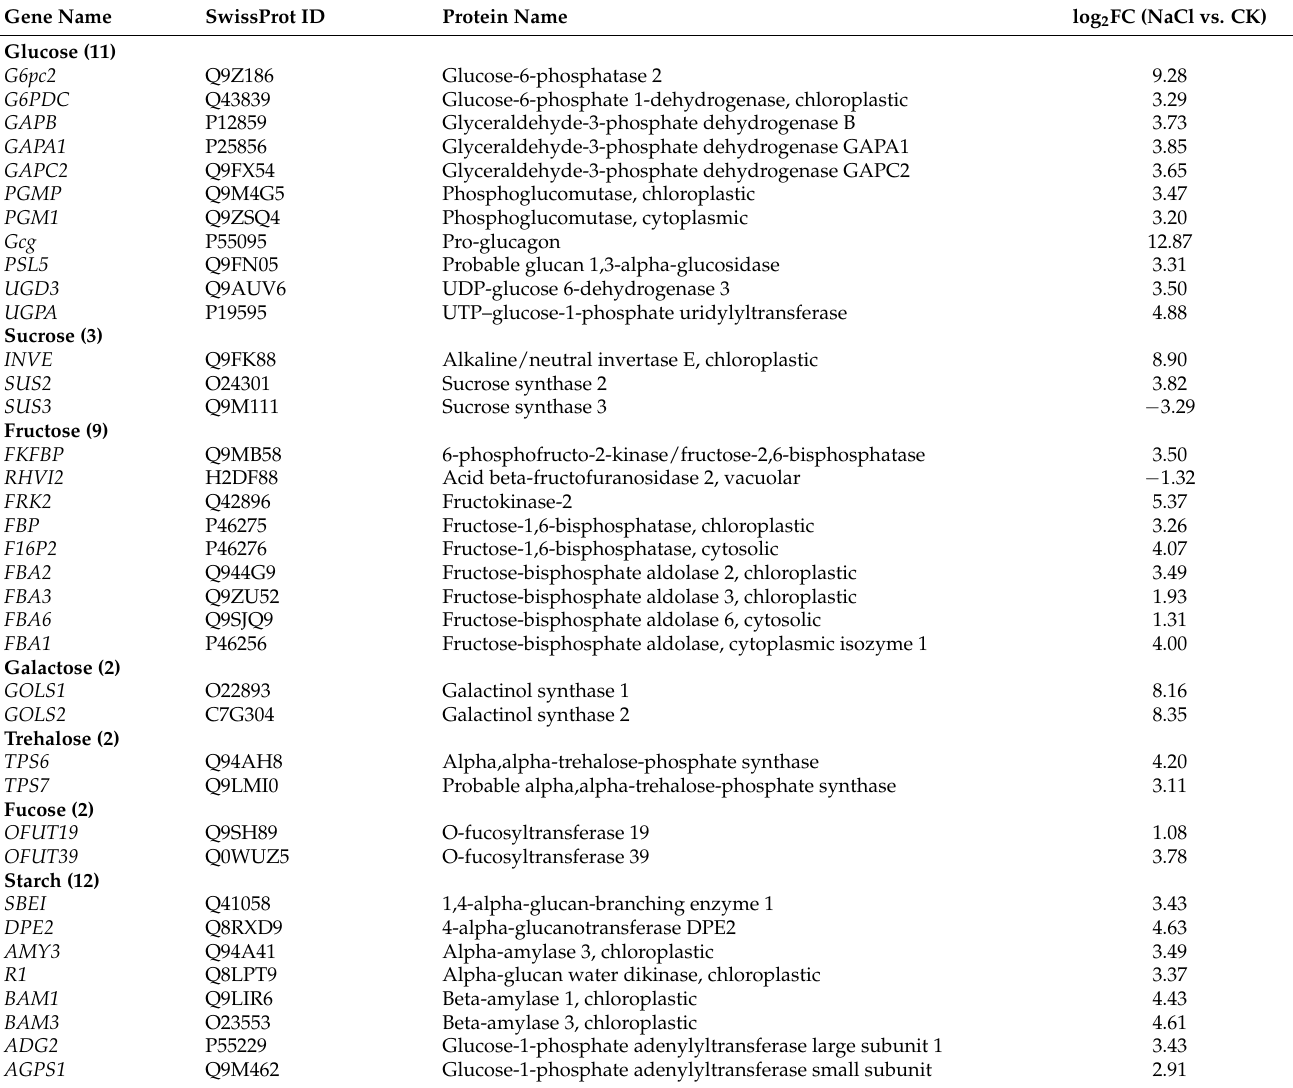
Table 4. Seventy-nine DEGs directly associated with soluble sugar and protein metabolism at 300 mmol/L NaCl vs.